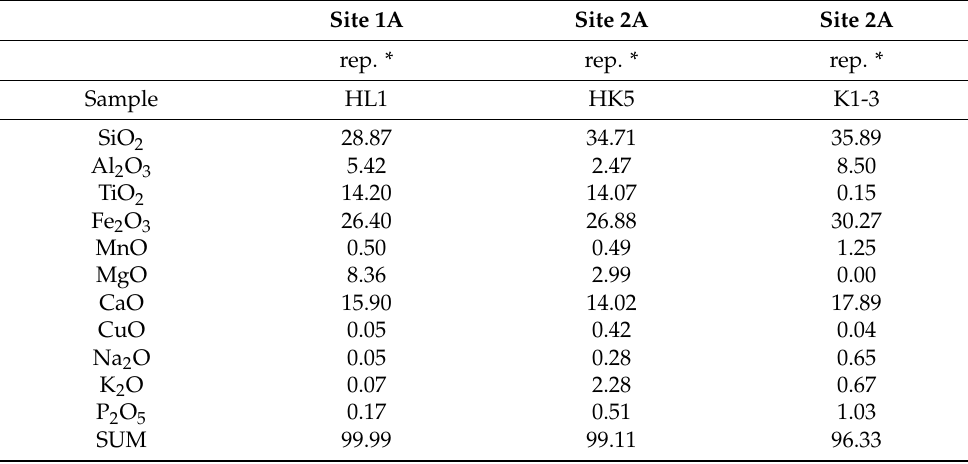
Table 7. Representative esseneite analyses from Sites 1A and